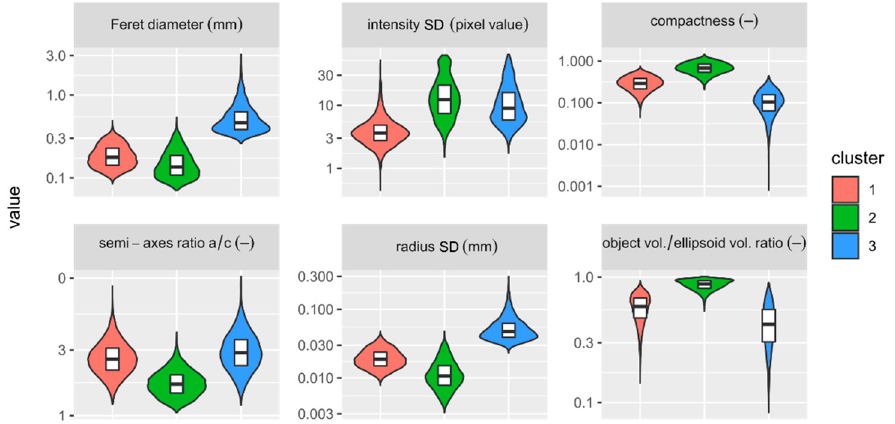
Figure 10. Distribution of the selected parameters in the clusters.